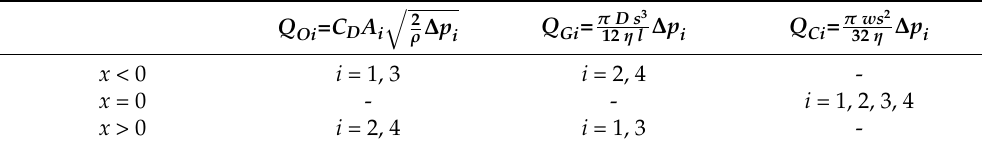
Table 1. Flow analysis for individual throttle edges and valve spool